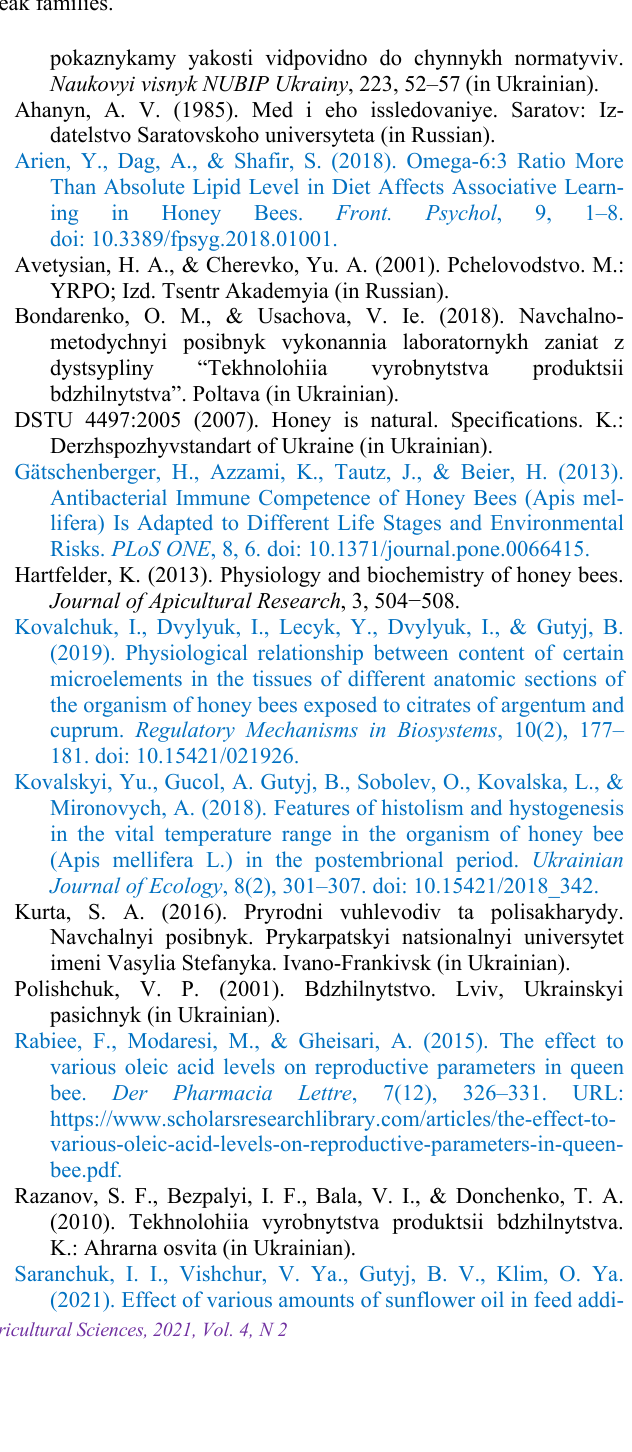
Fig.2. Comparison of data of sugars content in mature honey and inverting ability of bees: – indicators of strong families; – indicators of weak